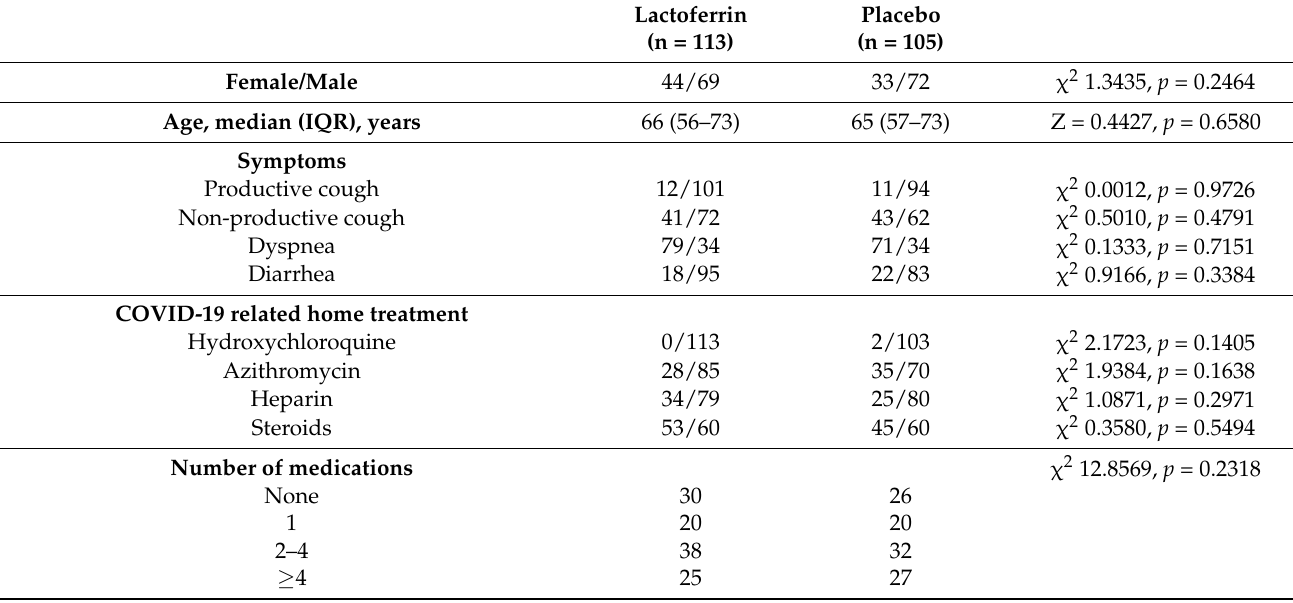
Table 2. Demographic and baseline characteristics of the studied population. Data are expressed as number of patients or median (interquartile range, IQR) when appropriate. * refers to data obtained with oxygen